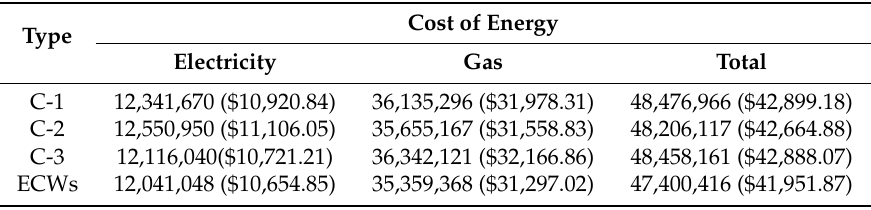
Table 8. Energy cost